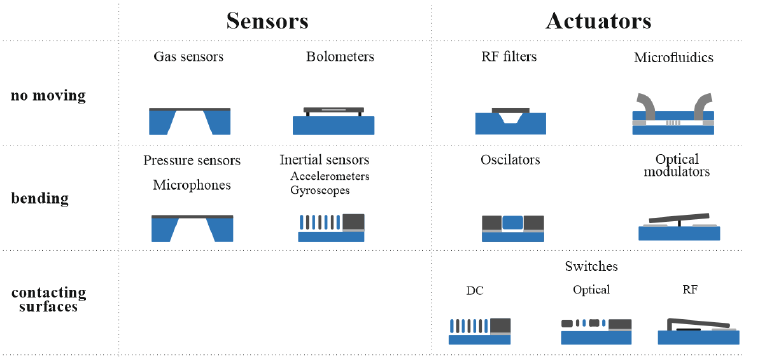
Fig. 8. Classification of main MEMS